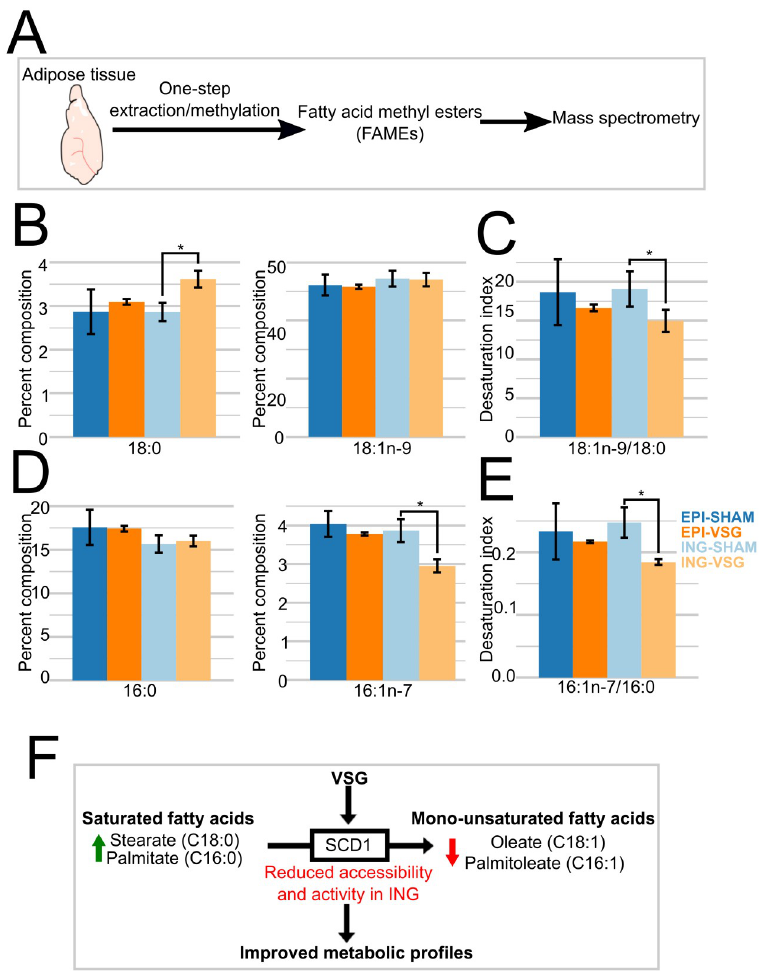
Fig 5. Reduced accessibility in Scd1 leads to less accumulation of unsaturated fatty acids. A. Experimental design of determining FAME profiles, using three samples per depot and treatment group. B. 18-carbon fatty acid profiles, and C, corresponding desaturation index. ( n = 3). D. 16-carbon fatty acid profiles, and E, corresponding desaturation index. ( n = 3). � p < 0.05. Two-tailed students t-test was performed for (C,D,E,F) comparing VSG to SHAM within ING or EPI adipose samples. F. Model for the contributions of VSG to metabolic health through functional accessibility changes at Scd1 .